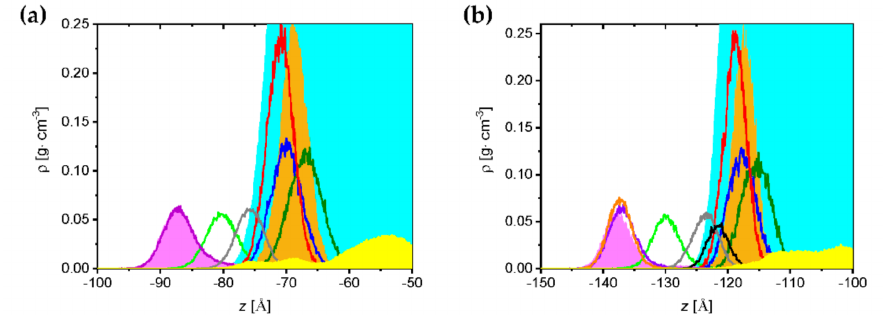
Figure 7. Partial density plots at the interface of SM/POPC ( a ) and SM/POPC/CHOL 30 mol% ( b ) monolayers interacting with GOTCAB. Color code; cyan area: water; magenta area: terminal CH 3 in the POPC lateral chains; violet line: terminal CH 3 in the SM lateral chains; orange line: terminal CH 3 in the CHOL lateral chain; green line: C=C in POPC; gray line: C=C in SM; orange area: PO 4 in POPC; red line: PO 4 in SM; black line: OH in CHOL; olive line: N(CH 3 ) 3 in POPC; blue line: N(CH 3 ) 3 in SM; yellow area: carbon atoms of the aglycone moiety in